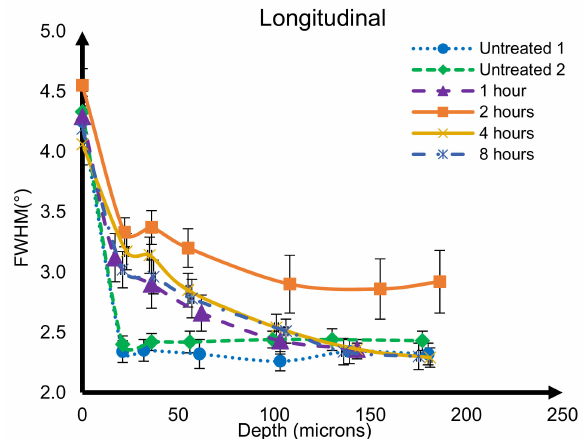
Figure 12. FWHM distribution of IN718 at − 130 mm in the longitudinal